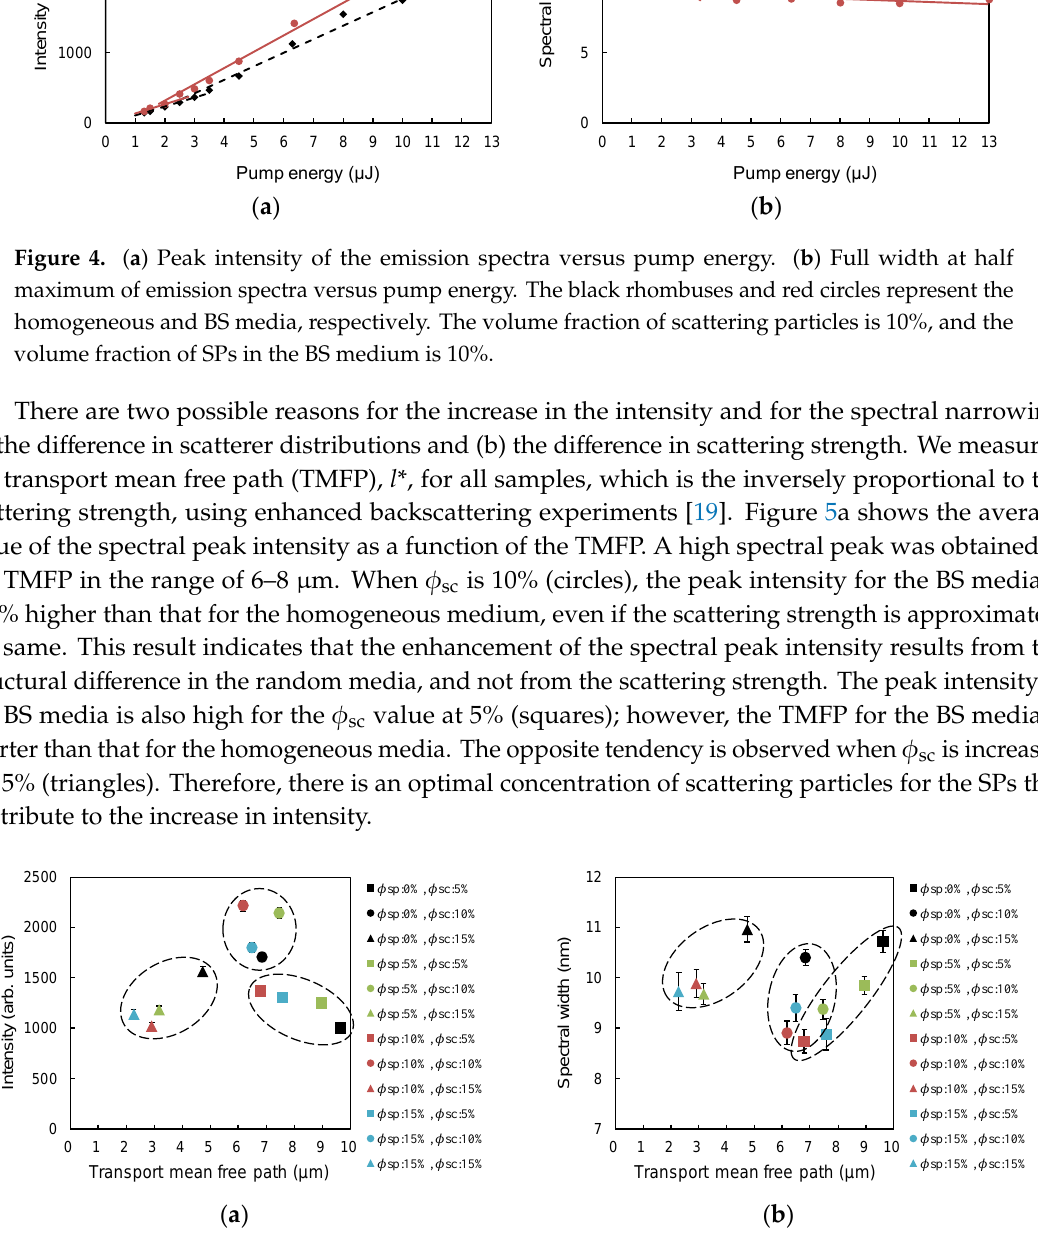
Figure 5. ( a ) Spectral peak intensity and ( b ) spectral width versus the transport mean free path (TMFP). Each dashed ellipse represents a group of the same volume fraction of scattering particles. The different colors represent the different volume fractions of SPs. The pumping energy and energy density are 4 µJ and 1.3 mJ/mm 2 , respectively. The error bars represent the standard errors.